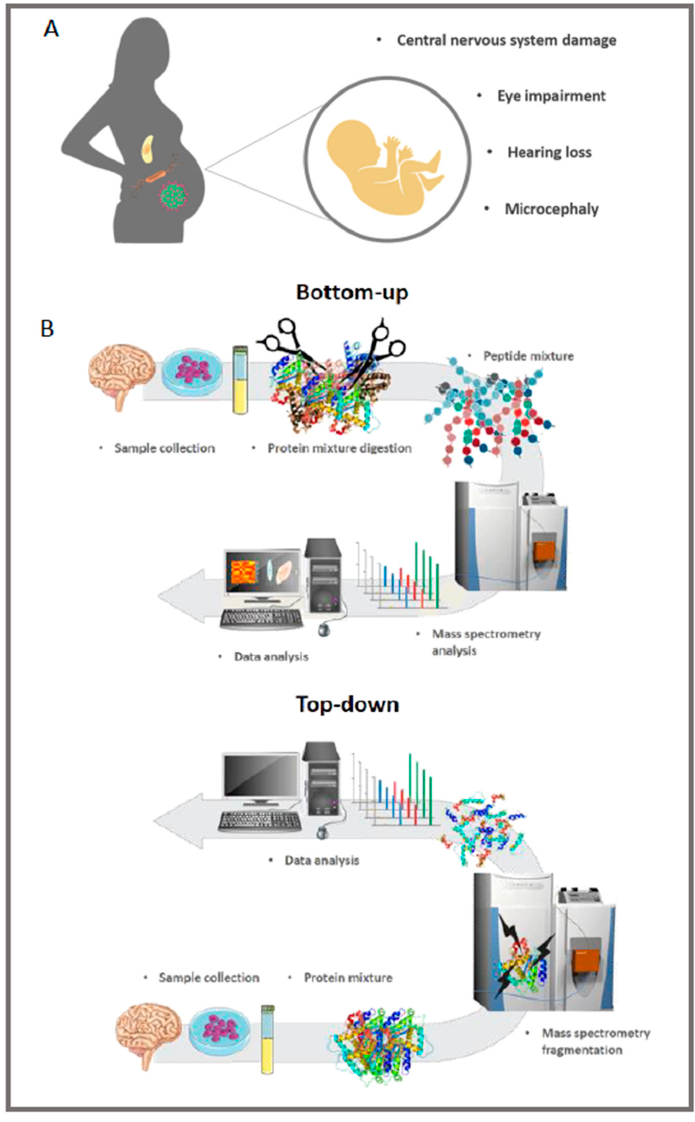
Figure 1. Most frequent symptoms related to TORCH (toxoplasmosis, "others", rubella, cytomegalovirus infection, and herpes simplex virus infections) diseases. Children can present these symptoms at birth or late, therefore medical follow-up is crucial ( A ). Main stages of bottom-up and top-down proteomic analysis. Different tissues, cell culture or fluids can be analyzed ( B ). Table 1. Main symptoms identified in neonates exposed to congenital infections. The + sign means that the indicated symptom has already been related to the disease; while the sign - means that the symptom has little or no relation. Zika virus (ZIKV), human immunodeficiency virus (HIV), human cytomegalovirus (CVM), herpes simplex virus (HSV).